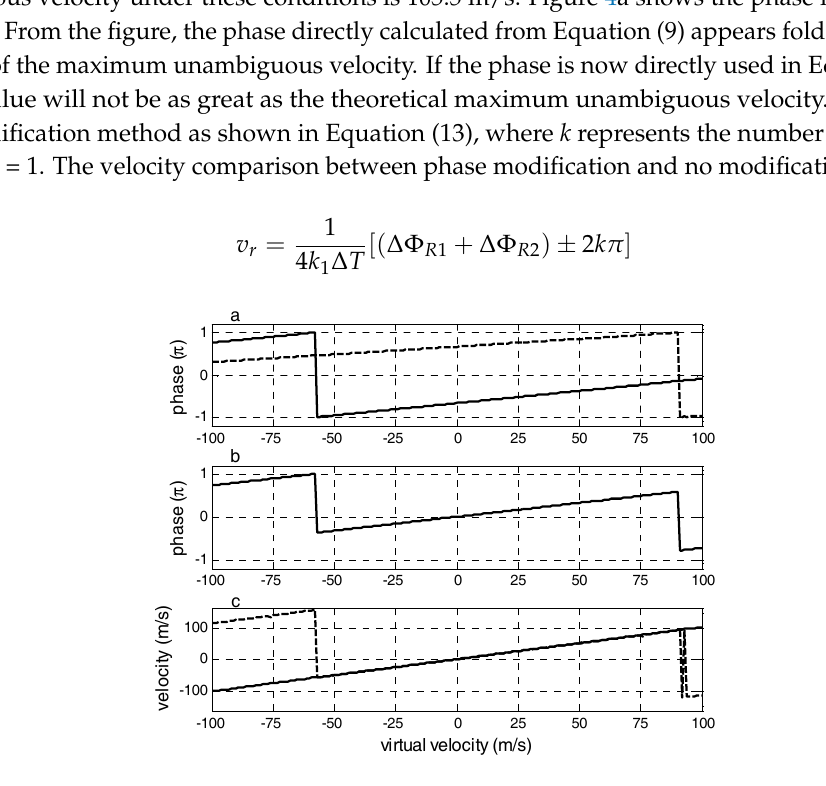
Figure 4. FDPP algorithm phase estimation and velocity estimation. ( a ) Phase estimation of ΔΦ R 1 and ΔΦ R 2 ; the solid line indicates ΔΦ R 1 and dotted line indicates ΔΦ R 2 ; ( b ) the phase sum of ΔΦ R 1 and ΔΦ R 2 and ( c ) the velocity estimation; a dotted line indicates the unmodified velocity and solid line indicates the modified result of velocity estimation.